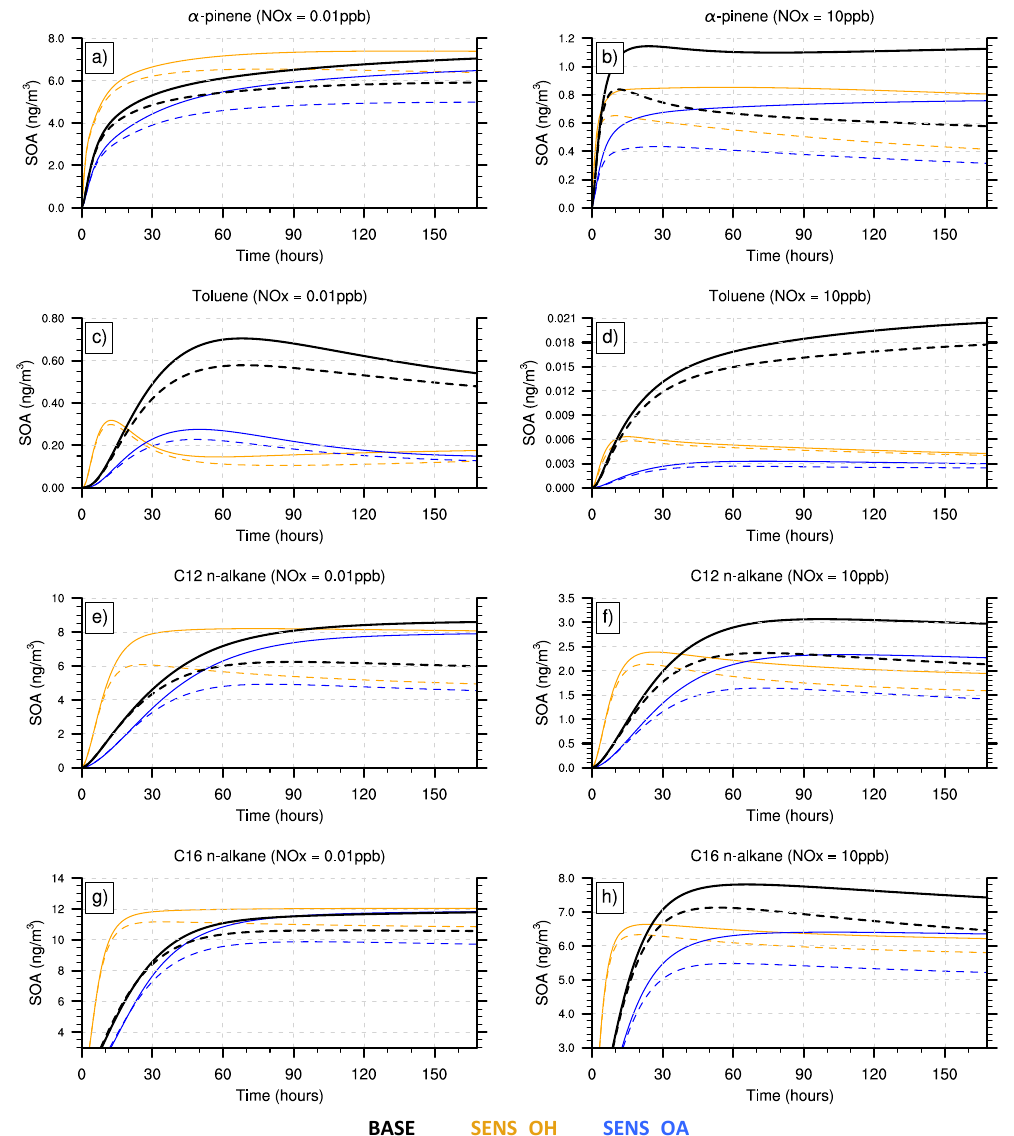
Figure 1. SOA formation from the oxidation by OH of 1ppt of α -pinene, toluene, C 12 and C 16 n -alkanes at low (0.01ppb) and high (10ppb) NO x levels. Plots compare GECKO-A simulations with (dashed lines) and without (solid lines) gas-phase photolysis of organics at the solar zenith angle of 45 ◦ (mid-latitudes) under constant daylight. To derive equivalent atmospheric summertime exposure of our experiment, the time axes should be multiplied by a factor of 2 (see Table 1). The reference simulation (BASE) is shown in black, and is compared to two sensitivity simulations testing for higher OH levels (SENS_OH in orange) and lower absorbing organic aerosol mass (SENS_OA in blue). See Table 2 for the description of various